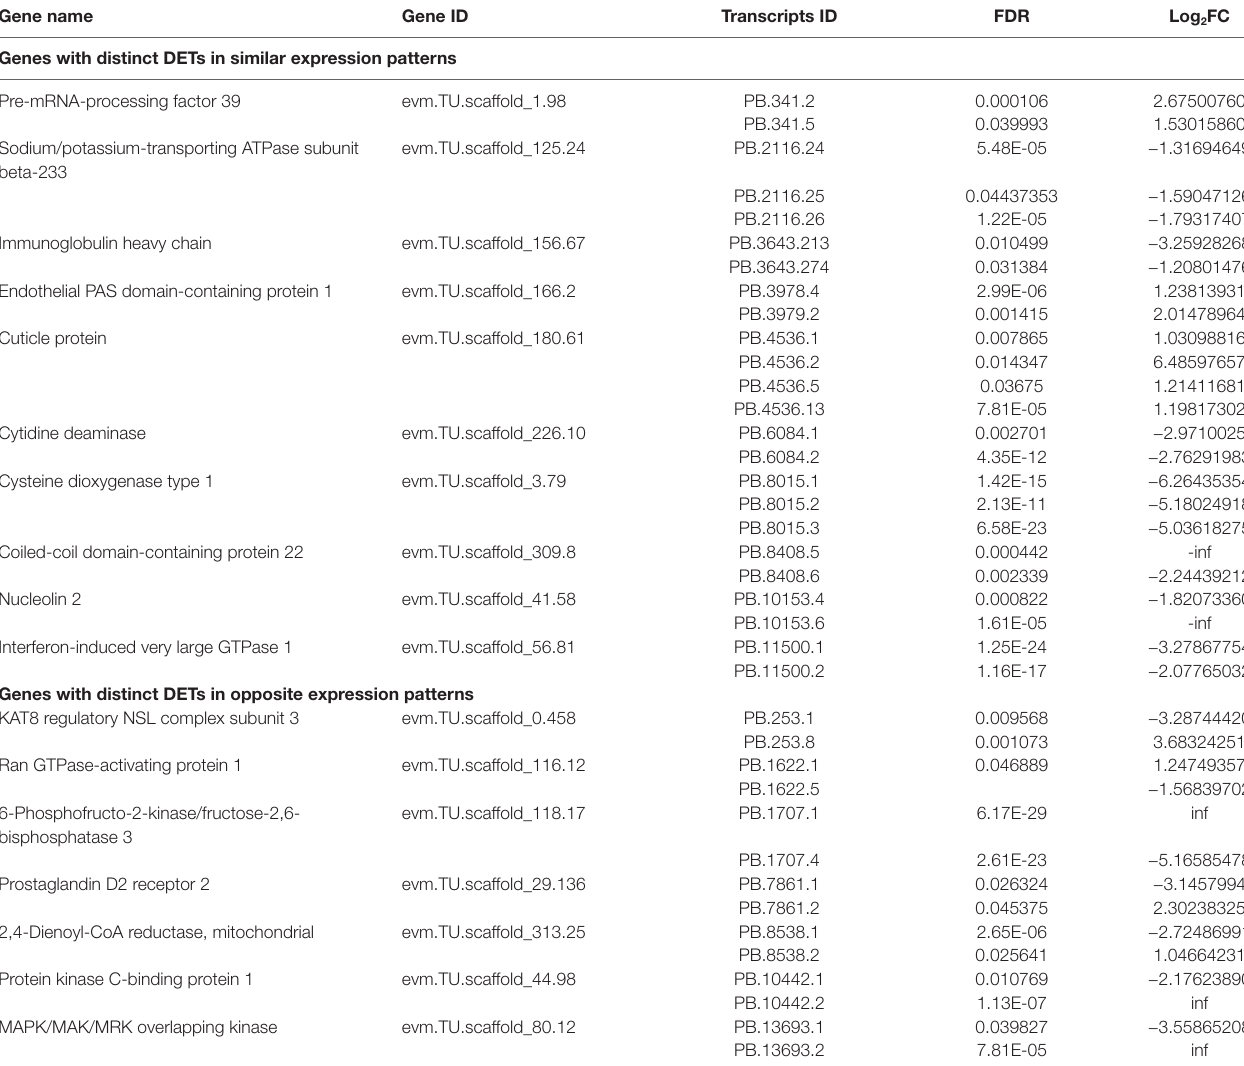
TaBLe 2 | List of genes with distinct differentially expressed transcripts (DETs) in SW relative to FW